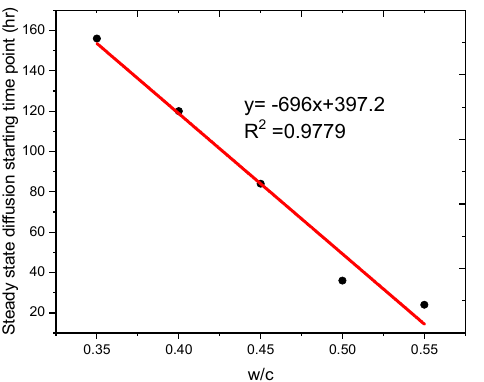
Figure 3. Cumulative chloride concentration in anode cell: ( a ) w/c=0.55 cement mortar samples, ( b ) w/c=0.50 cement mor- tar samples, ( c ) w/c=0.45 cement mortar samples, ( d ) w/c=0.40 cement mortar samples, ( e ) w/c=0.35 cement mortar sam- ples.